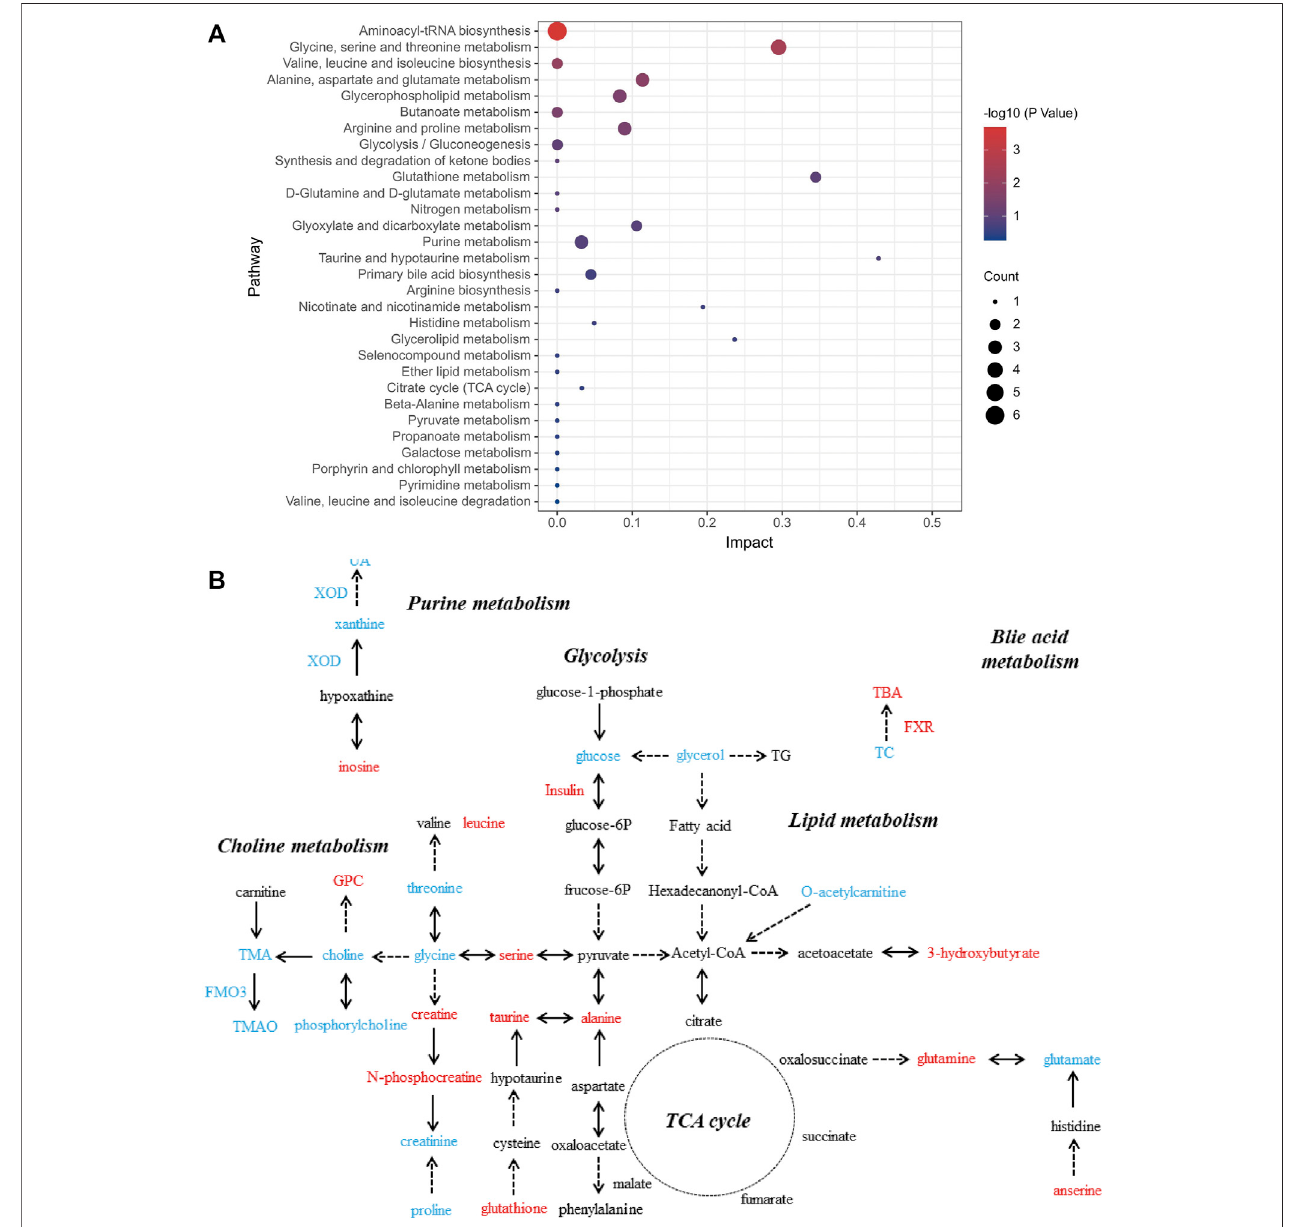
FIGURE3 | Analysisofrelated metabolic pathways. (A) Pathway analysis forgroup C vs. M byusing theKEGG database. The horizontal axis represents impact; a higherimpactindicatesagreaterdegreeofenrichment.ThepointsizerepresentsthenumberofdifferentiallyexpressedmetabolitesinKEGG,andthecolorsofthepoints correspond to different p -value ranges. (B) Which metabolites have caused change after treatment with salidroside, tyrosol, and hydroxytyrosol for 12 weeks is shown. The red font represents the upregulation of differential metabolites or biochemical indexes after administration, while the blue font represents the reverse.